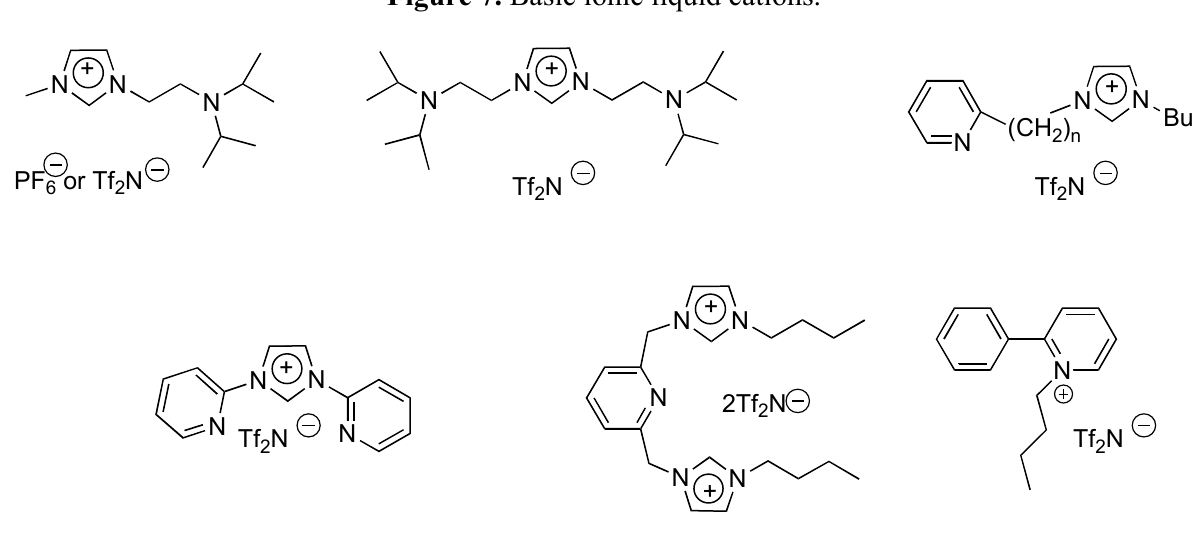
Figure 7. Basic ionic liquid